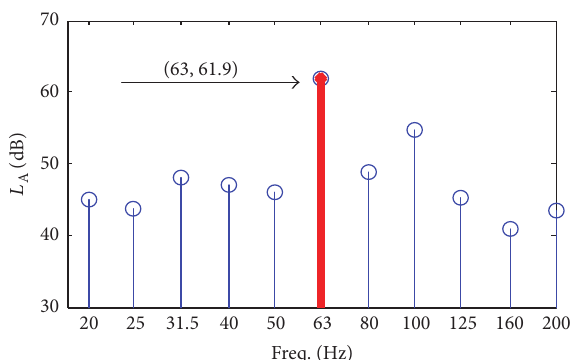
Figure 8: A-weighted sound pressure levels on 1/3 octave band at measurement point E0.